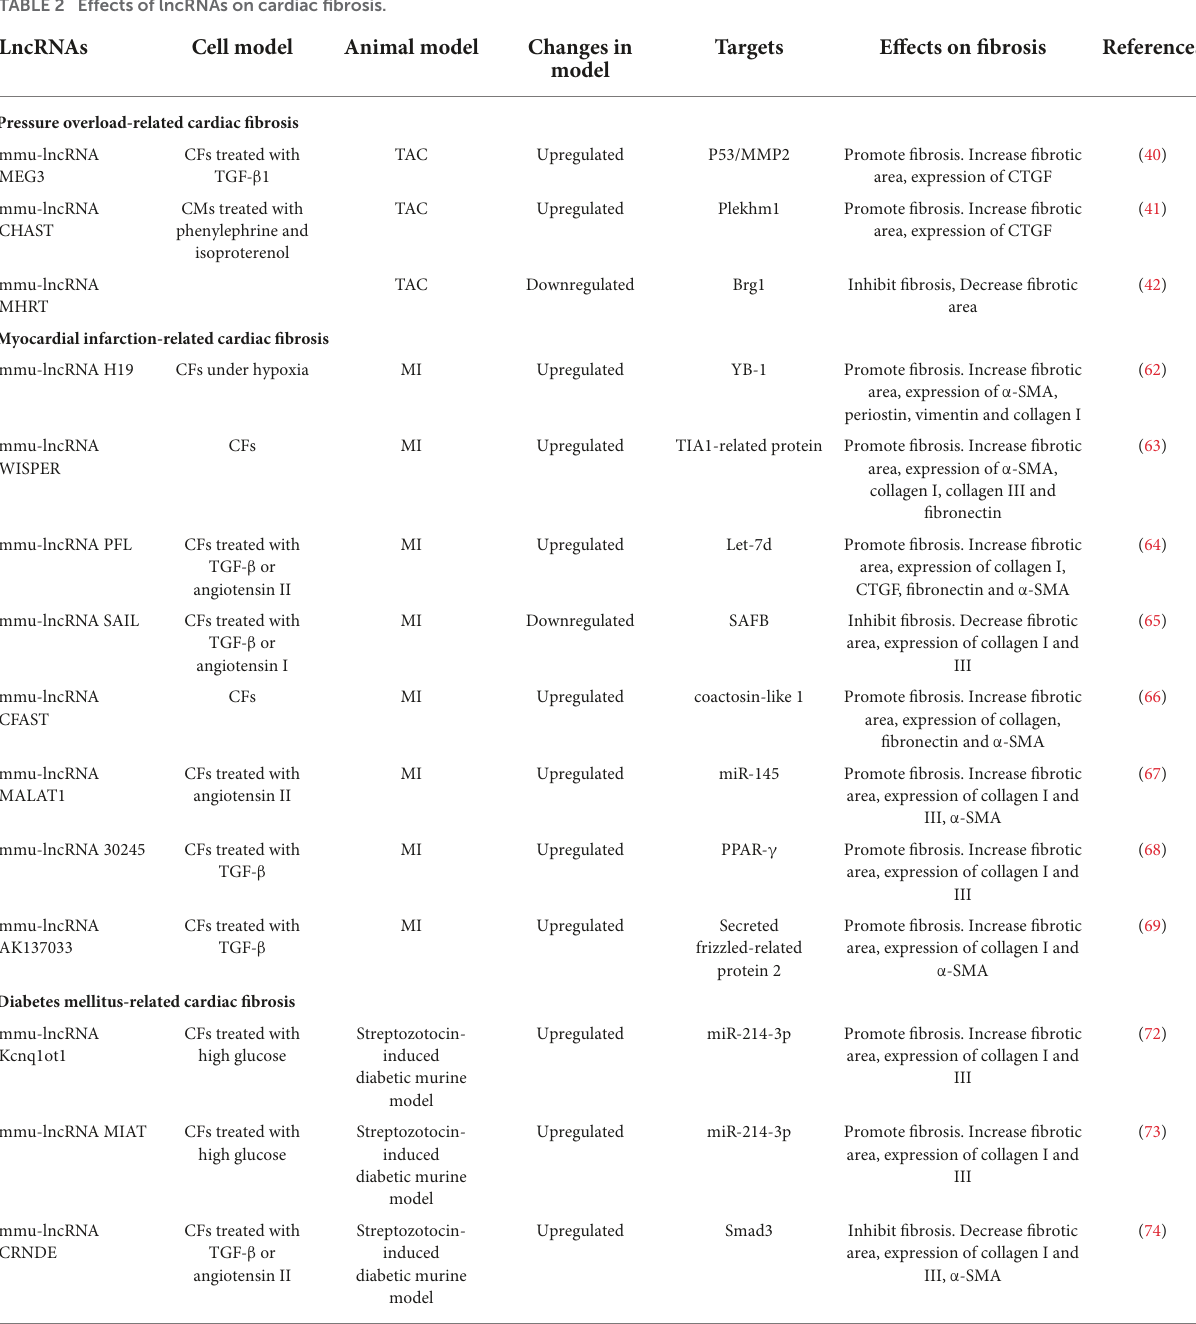
TABLE 2 Effects of lncRNAs on cardiac